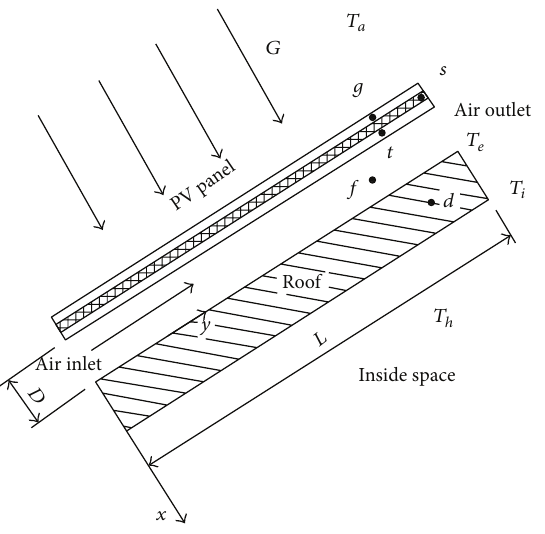
Figure 15: Model of the ventilated air gap in the BIPV.